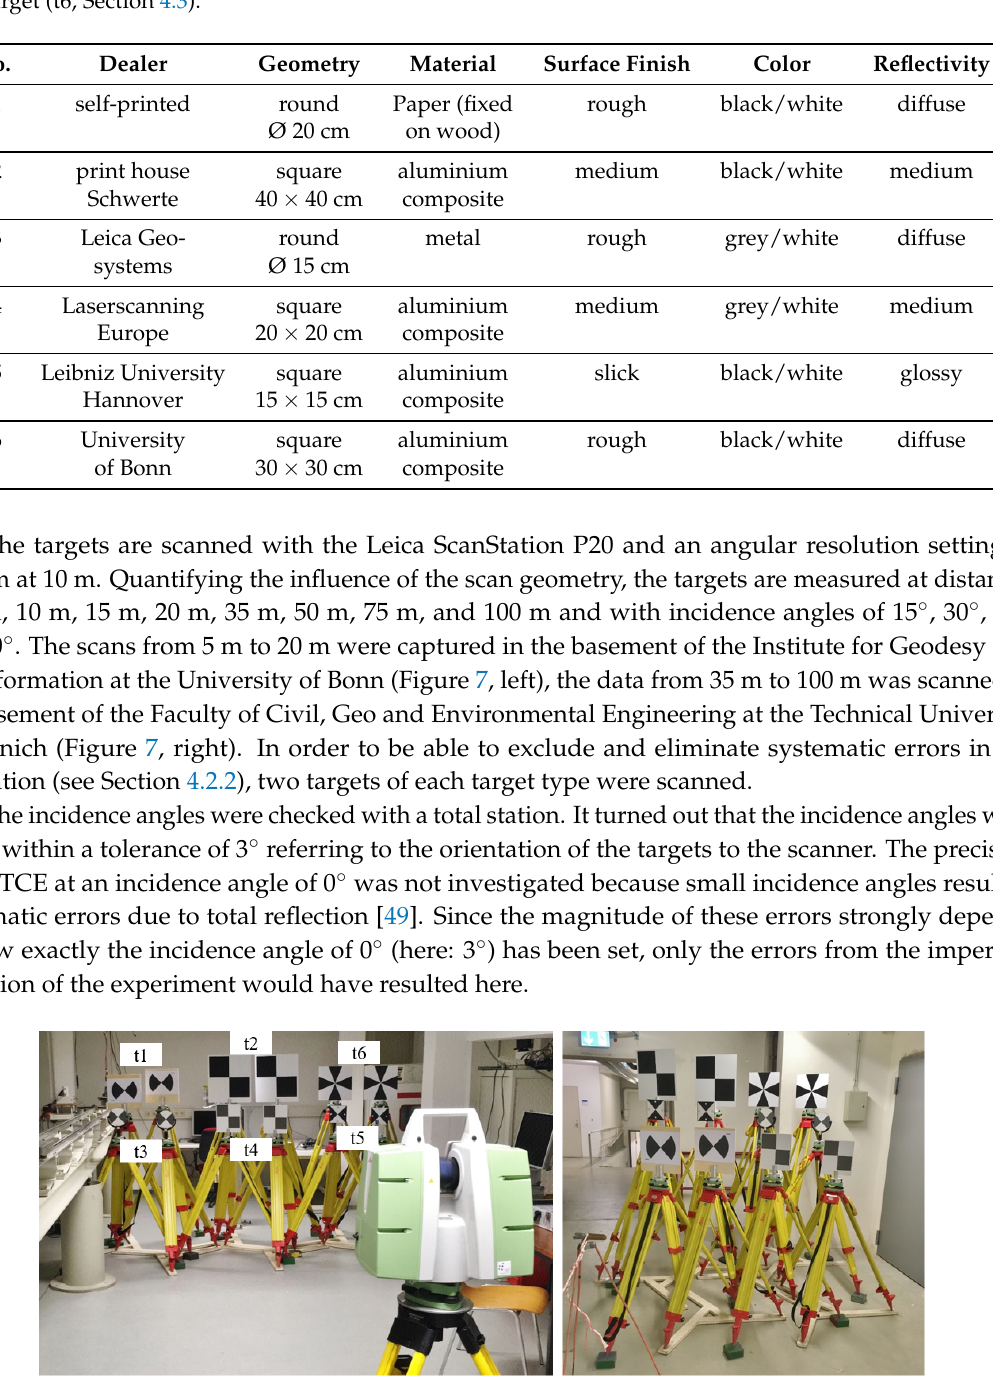
Figure 7. Photos of the experimental setup in the basements of the University of Bonn ( left ) and of the Technical University of Munich ( right